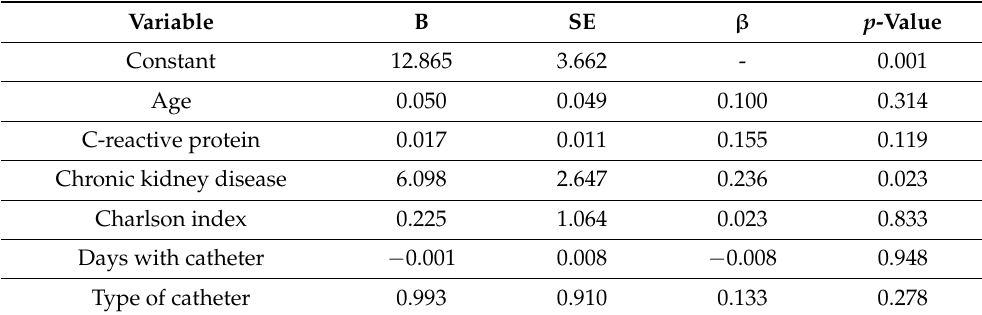
Table 4. Multiple regression analysis of the combined influence of clinical characteristics and bio- chemical variables on plasma galectin-3 concentrations in patients with a central venous catheter. Model summary: r = 0.400; p = 0.005.